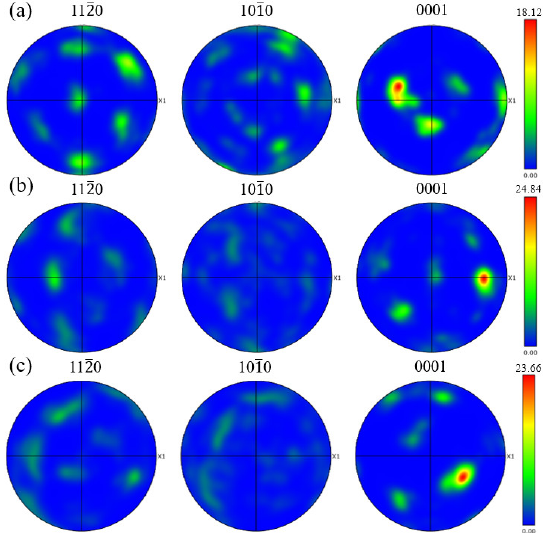
Figure 5. Pole figures of ( a ) initial, ( b ) deformed with strain rates 1620 s −1 , and ( c ) 2820 s −1 samples. Table 4. Microstructure parameters of the Ti-6Al-1Mo-2Zr-0.55Fe−0.1B alloy in the initial and de- formed